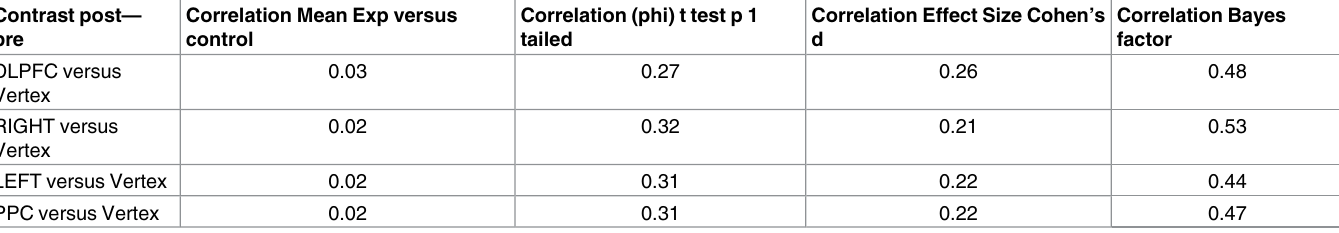
Table 4. Correlation between accuracyand confidence table of t tests, effect sizes and Bayesfactors analysesbetween conditions and control (NB for the Rounis study, post—pre TMS accuracy-visibility correlation DLPFC versus sham control was -0.05). Contrast post—